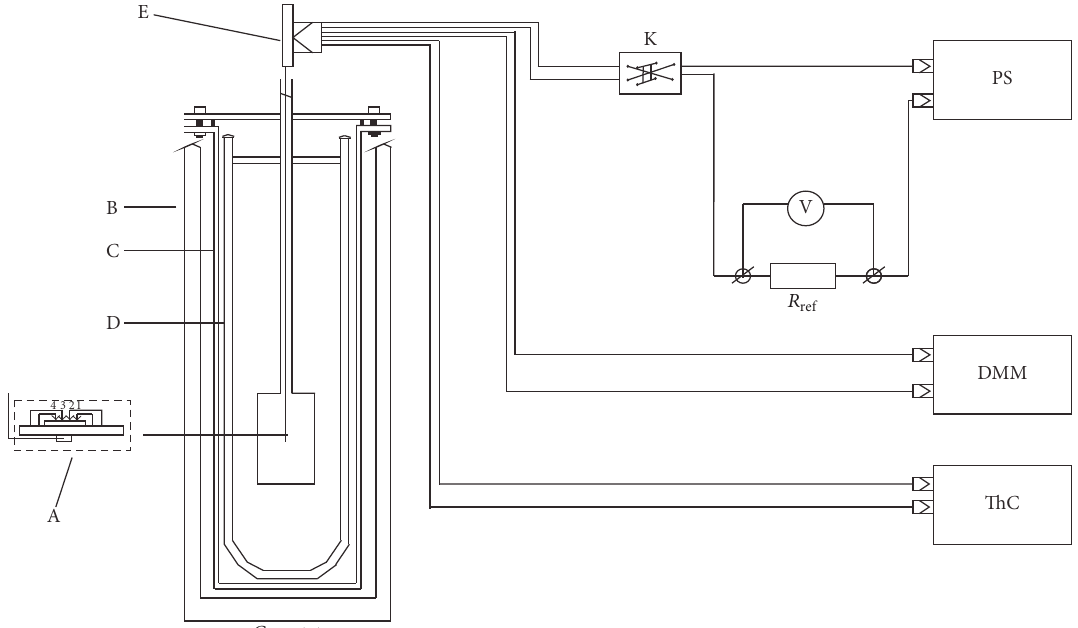
Figure 4: Experimental setup for the conductivity of the carbon nanotubes investigation. PS: power source, DMM: digital multimeter, ThC: thermocouple, K: key-commutator allowing to change the direction of current, A: plate with sample and thermocouple, B: case, C: metal frame, D: glass capsule, E: holder with electrical contacts.